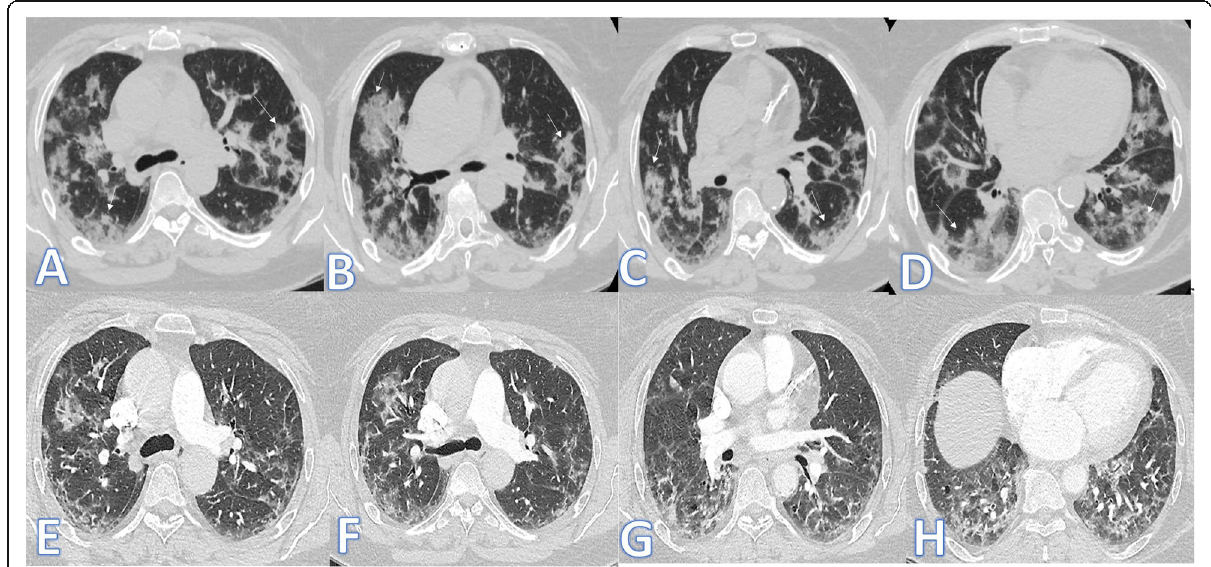
Fig. 1 Fifty-five-year-old female: she has DM, HTN, and IHD; peak CT severity score 12; consolidation/crazy-paving score 10. She was admitted to the ICU; laboratory results show lymphopenia, high CRP, D -dimer, serum ferritin, and high-sensitivity troponin. Steroid was given; length of stay during hospitalization is 15 days. Peak CT during admission ( a – d ) showed bilateral consolidation patches more at the lower lobes with a crazy- paving appearance (arrows). Follow-up CT 3 weeks after discharge ( e – h ) shows lung fibrosis with a coarse reticular pattern mainly dependent (arrows).